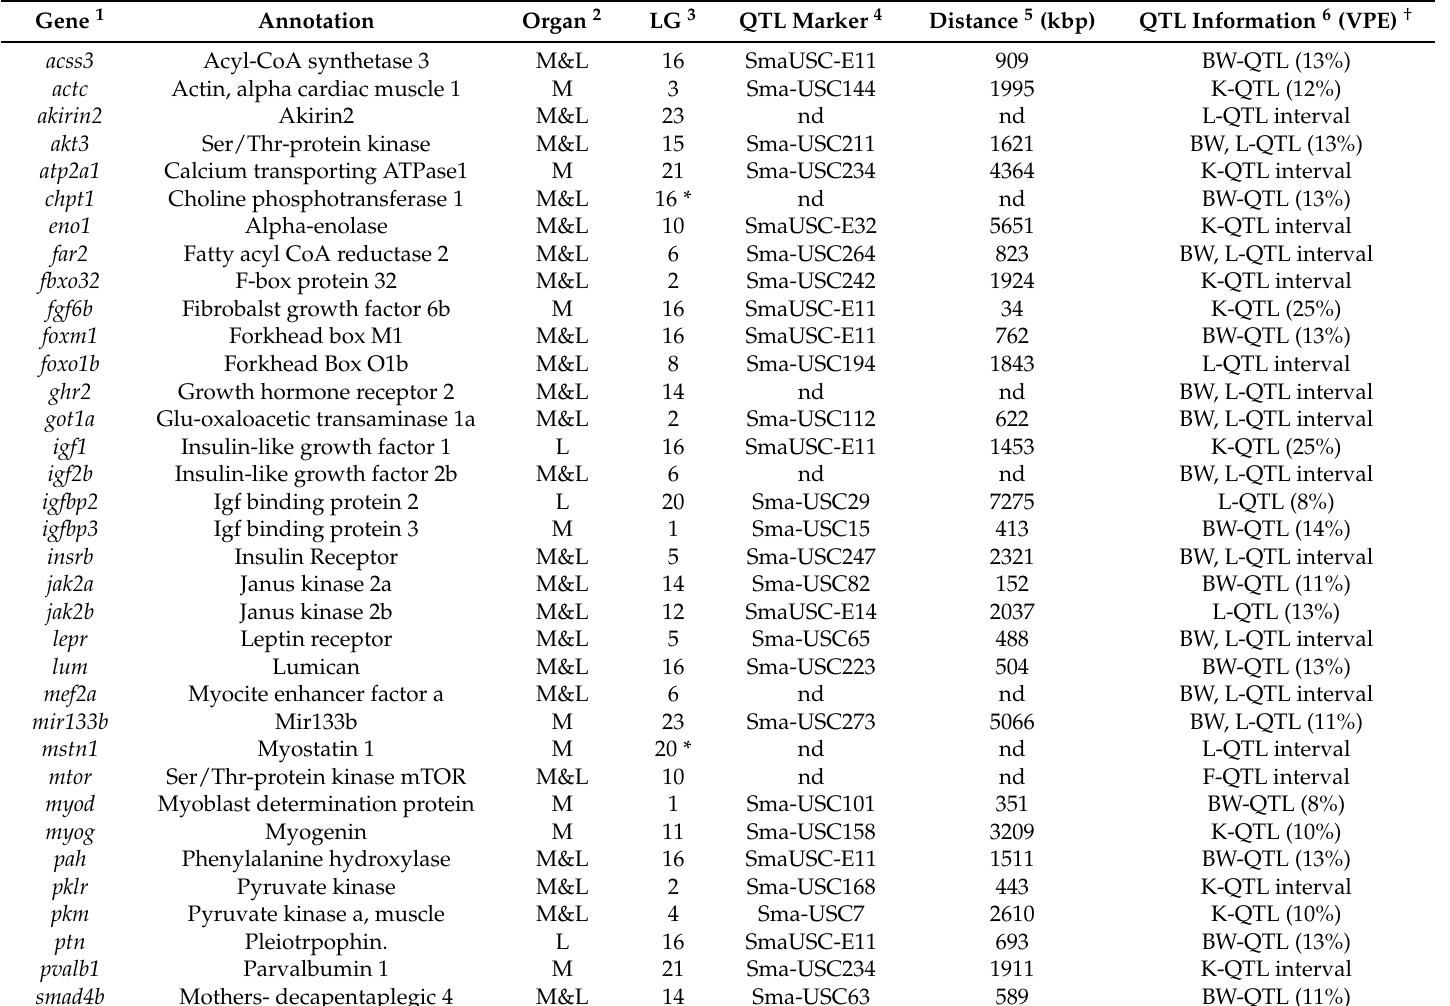
Table 2. Growth-related expressed genes selected for SNP screening in